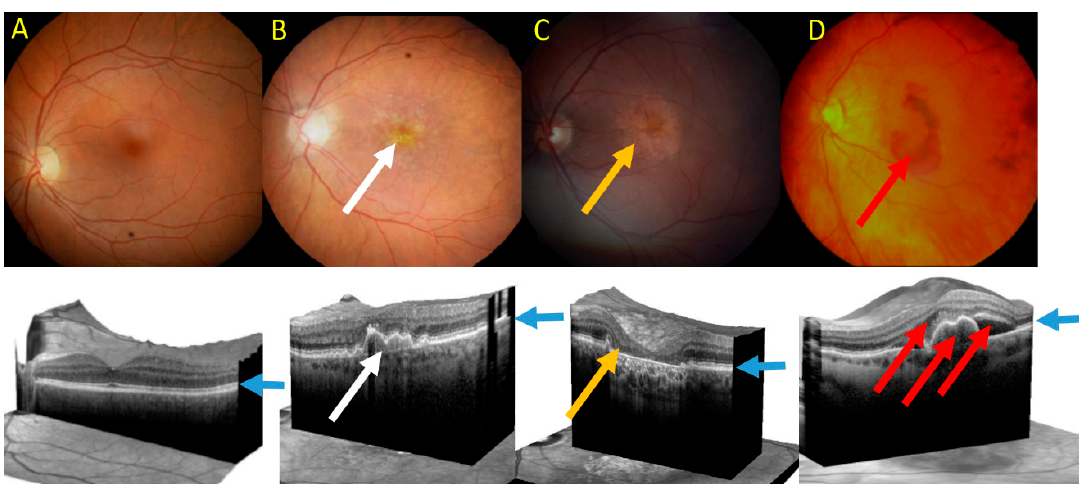
Figure 5. Fundus photograph of healthy macula ( A ) and macula of age-related macular degeneration (AMD) in its early form with several drusen deposits (white arrow) ( B ), geographic atrophy (GA) with typical GA lesions (yellow arrow) ( C ) and wet form with subretinal pigment epithelium (RPE) and subretinal and intraretinal fluids and hemorrhage (red arrow) ( D ). Lower panel—corresponding images of optical coherence tomography. Blue arrows point at the RPE layer.